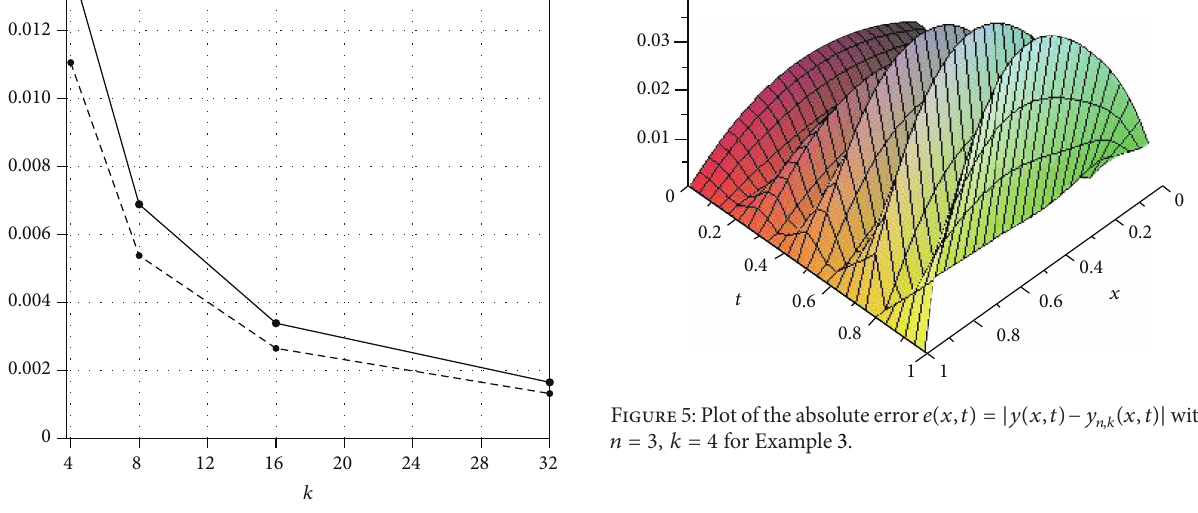
t = 0.5 t = 0.75 Figure 3: Plot of the maximum absolute errors for different values of 𝑘 with 𝑡 = 0.5, 0.75 and 𝑛 = 3 for Example 2.